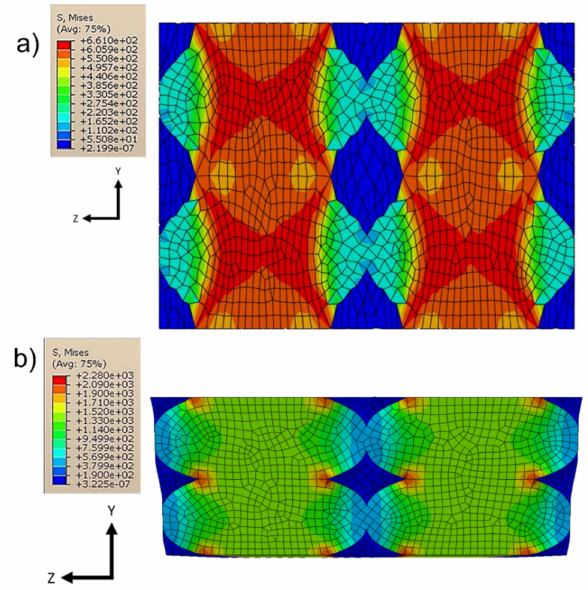
Figure 16. Von Mises stresses for E 22 ( a ) and G 12 ( b